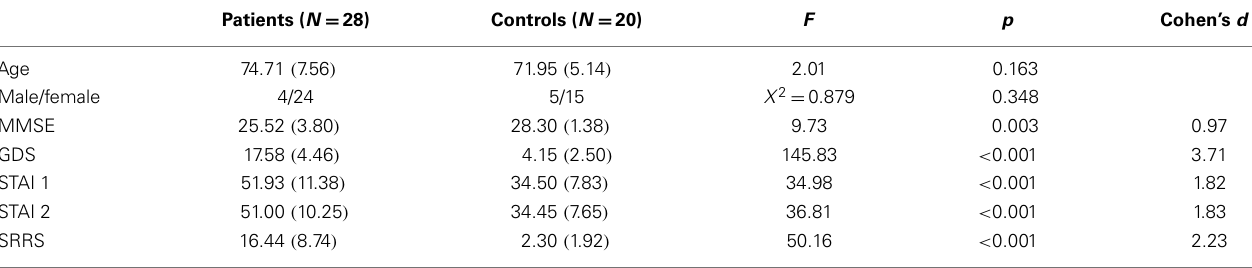
Table 1 | Demographic and clinical variables of patients and controls .